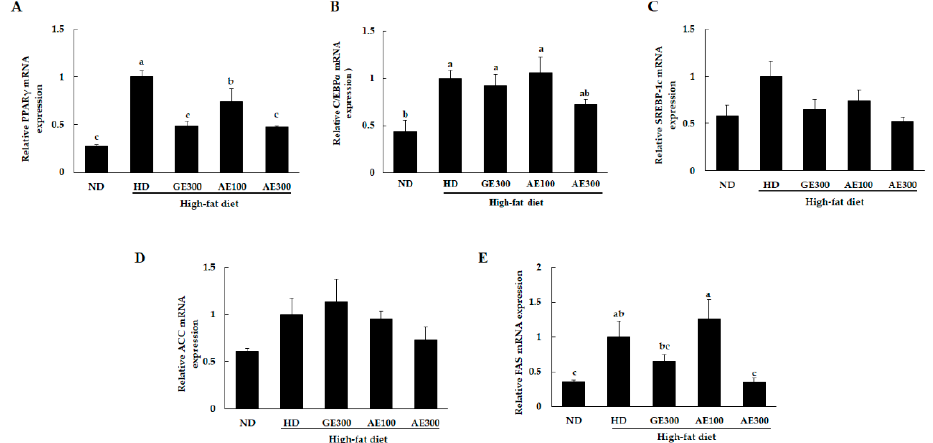
Figure 4. Effect of AE on the mRNA expression of genes involved in lipogenesis in the adipose tissue of the experimental mice. Mice were fed as previously indicated. ( A ) PPAR γ , ( B ) C/EBP α , ( C ) SREBP-1c, ( D ) ACC, and ( E ) FAS. ND, normal diet, HD, high-fat diet, GE300, high-fat diet + Garcinia 300 mg/kg b.w, AE100, high-fat diet + 100 mg/kg b.w, AE300, high-fat diet + 300 mg/kg b.w. Values are expressed as mean ± SEM, n = 5. The varying superscript letters indicate a statistically significant difference among the groups by Duncan’s test of ANOVA, p < 0.05.